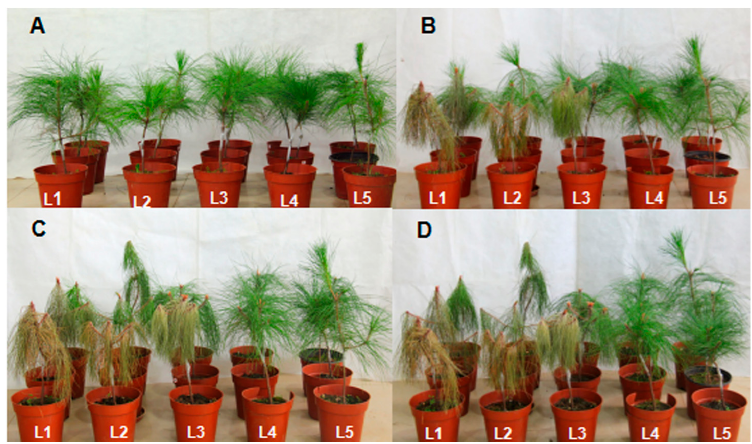
Figure 7. Symptoms of P. massoniana inoculated with different PWN treatments. ( A ) Symptoms after 0 day of inoculation; ( B ) Symptoms after 21 days; ( C ) Symptoms after 26 days; ( D ) Symptoms after 30 days. Pines inoculated with: L1, fungus B. xylophilus ; L2, B. xylophilus treated with S. maltophilia NS PmBx 03; L3, aseptic B. xylophilus ; L4, S. maltophilia NSPmBx 03; and L5, sterile water.